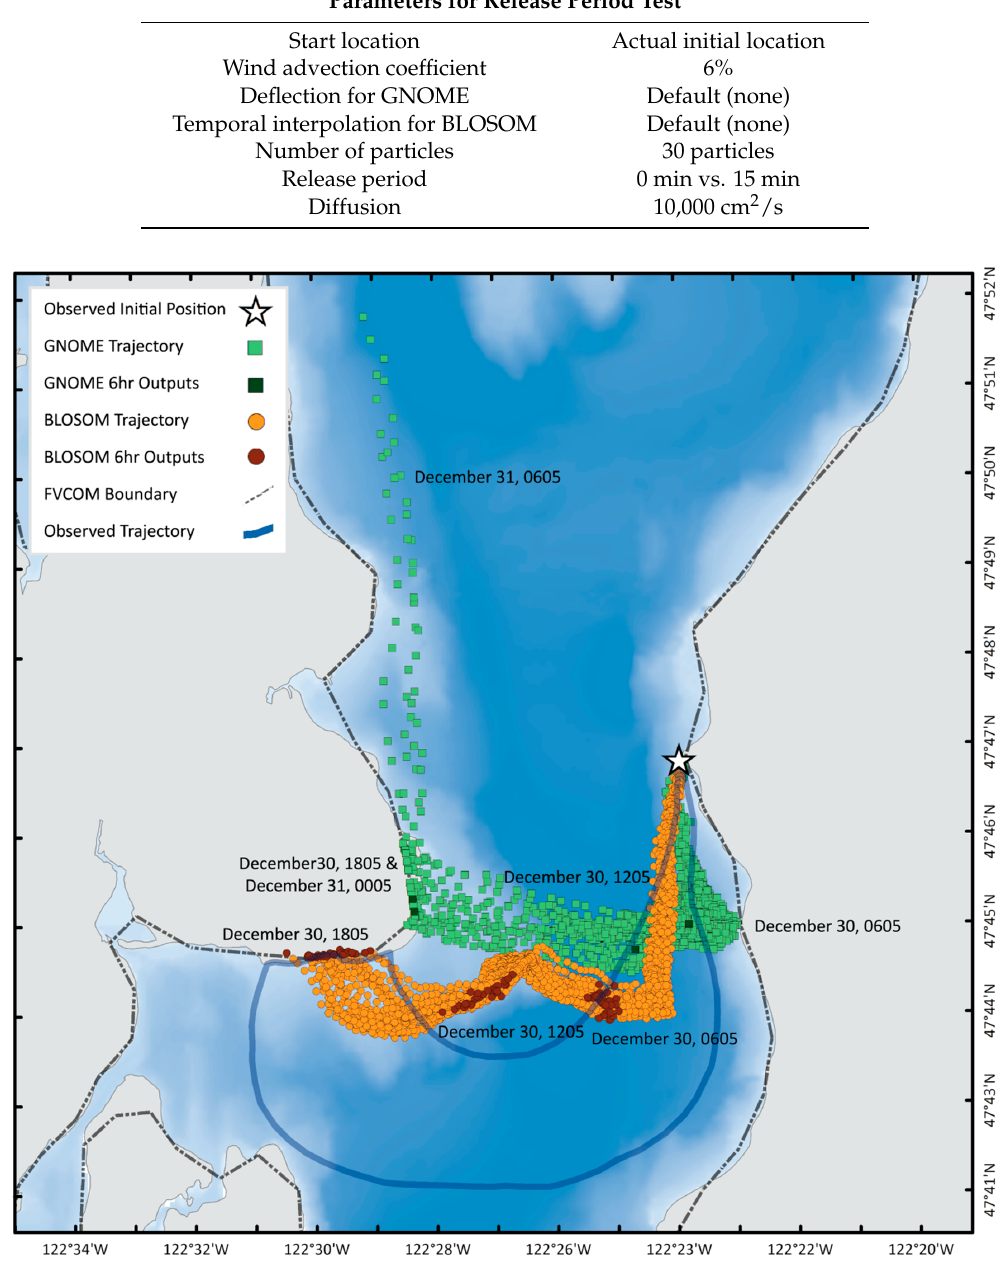
Table 12. Parameters for diffusion coefficient test.